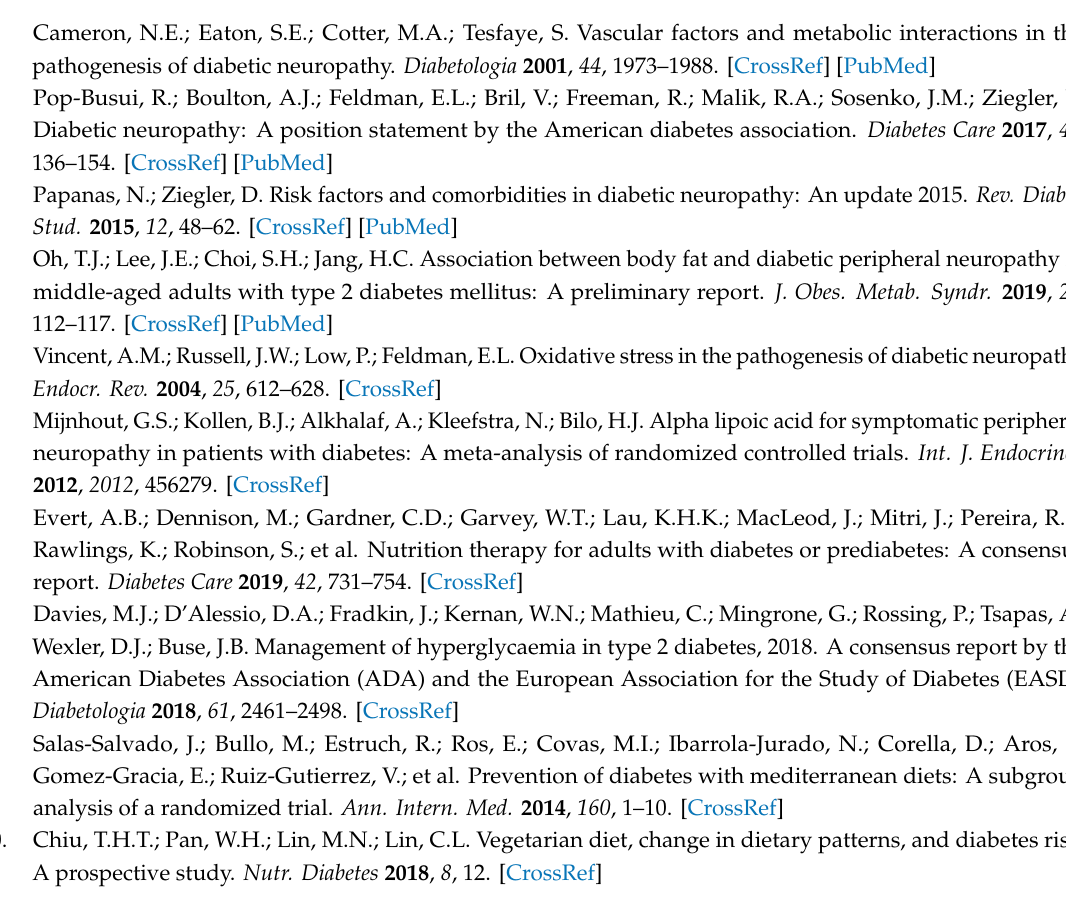
Table S1: Clinical and biochemical data of individuals according to the presence of DPN. Table S2: Use of lipid-lowering drugs in individuals according to the presence of DPN. Table S3: Use of antidiabetic drugs in individuals according the the presence of